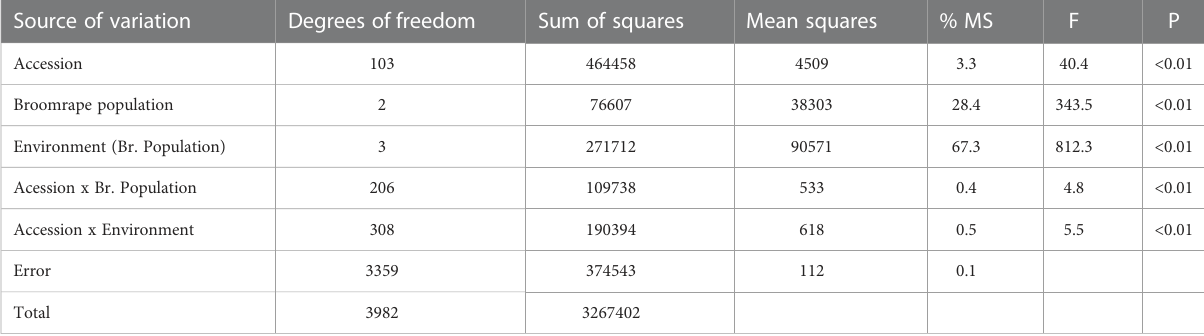
TABLE 1 Analysis of variance for the number of emerged broomrape shoots in a set of 104 sun fl ower accessions evaluated for three broomrape populations in two environments for each population. Source of variation